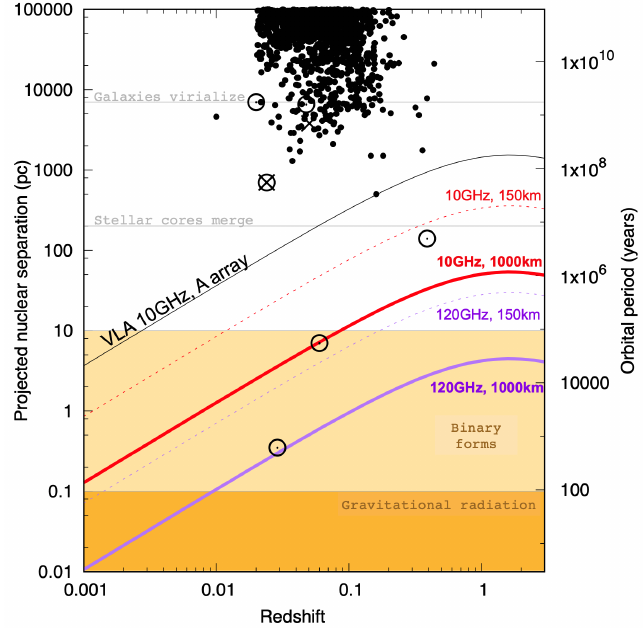
Figure 14. A compilation of candidate AGN pairs to date shown in projected nuclear separation— redshift space. The dual AGN are indicated by their discovery method: optical/near-infrared (dots, from Liu et al. [224]), X-ray (circles), and radio (crosses). The colored dashed and thick curves represent the resolution limits of the ngVLA at different frequency–baseline configurations with the VLA (10 GHz, A array; thin black line) as a comparison. Critical stages in binary formation and evolution are marked as horizontal lines. Only a handful of duals and binaries have been identified with nuclear separation below 1 kpc, so a key area of research would be to locate these SMBH pairs in mergers and post-mergers using new multiwavelength facilities with enhanced resolving power in the coming decade. Figure adapted from Burke-Spolaor et al. [229] with